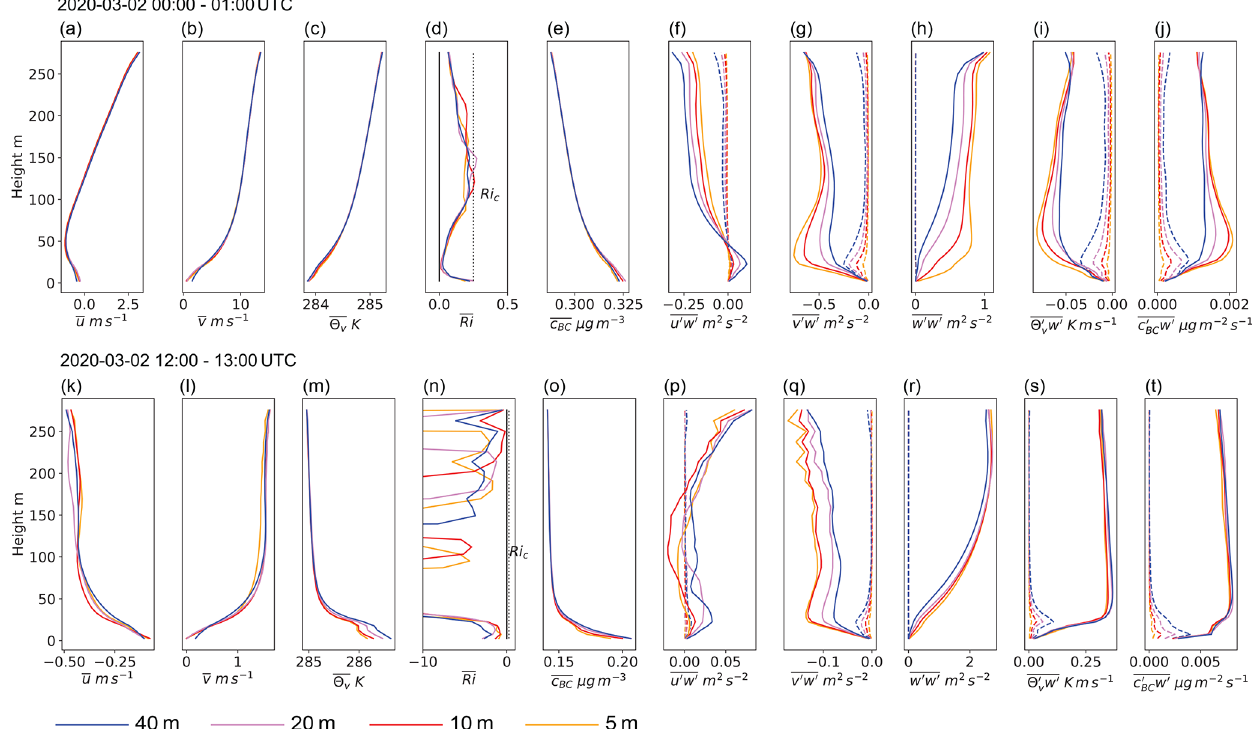
Figure 16. Vertical plots of horizontally averaged statistics for two different dates: velocity components u (a, k) and v (b, l) , virtual potential temperature (c, m) , Richardson number (d, n) , concentration of BC (e, o) , and the turbulent statistics for vertical mixing of momentum (f, g, h, p, q, r) , virtual potential temperature (i, s) and BC (j, t) , respectively. For the turbulent statistics, dashed lines are for the subgrid-scale (sgs) contribution, while the solid lines show both the sgs and grid-scale